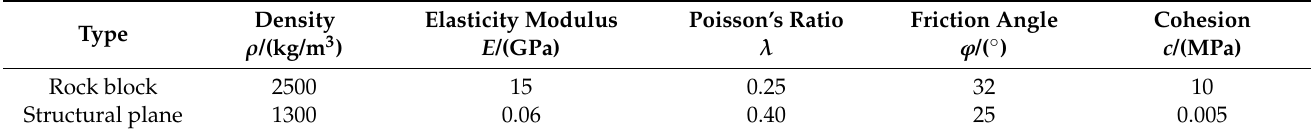
Table 3. Materials